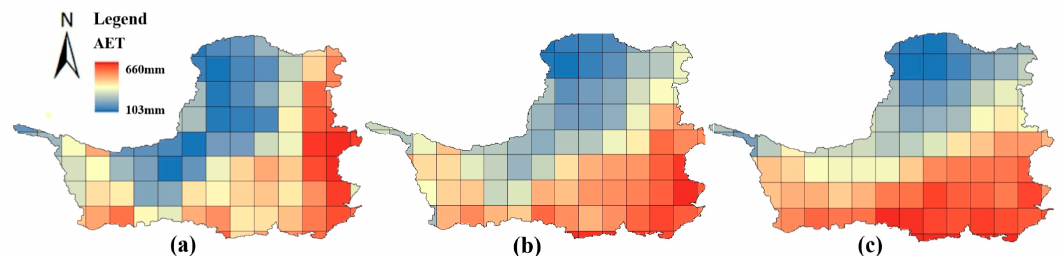
Figure 5. The spatial distribution of the estimated annual AET in the three stages: ( a ) the spatial distribution of AET in the initial stage after the Grain for Green Project launched (2003–2006), ( b ) the spatial distribution of the AET in the middle stage after the Grain for Green Project launched (2007–2010), and ( c ) the spatial distribution of the AET in the late stage after the Grain for Green Project launched (2011–2014).